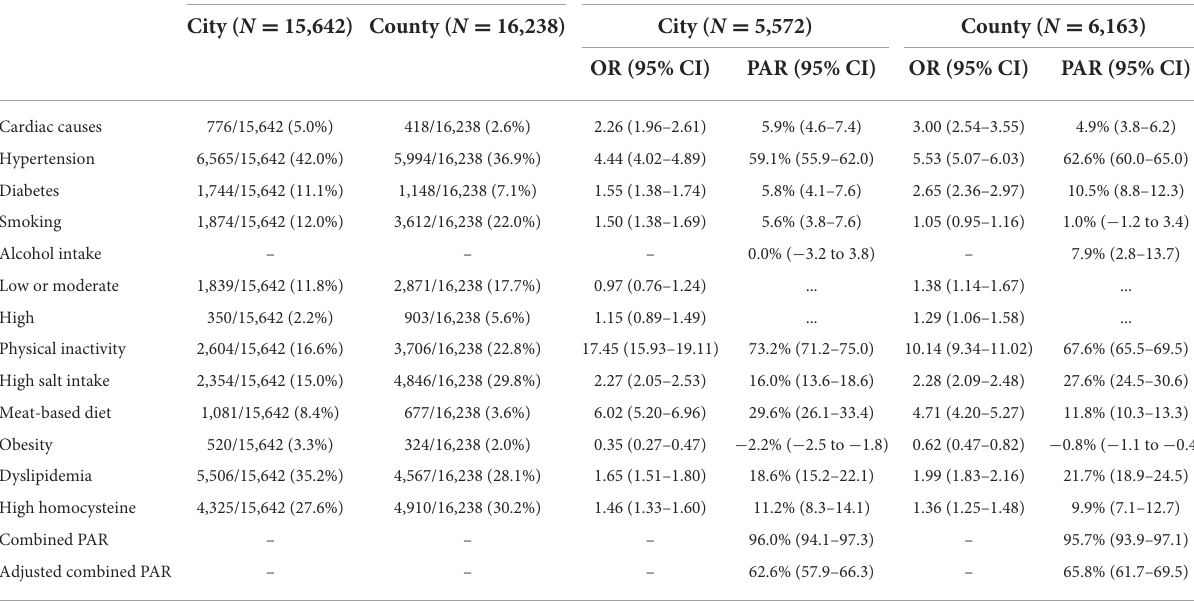
TABLE 3 Risk factors for all stroke in urban and rural